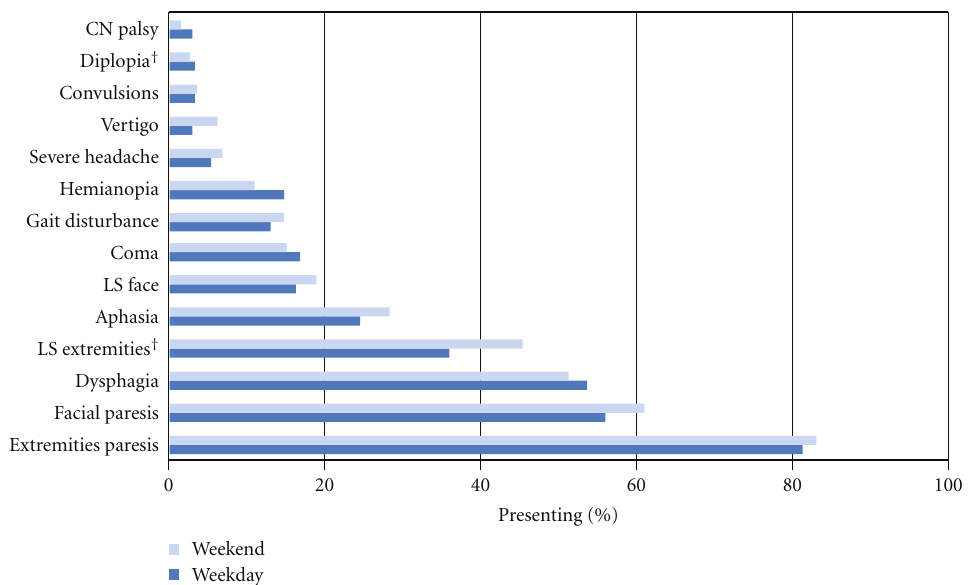
Figure 1: Di ff erences in percent of ischemic strokes presenting with selected symptoms on weekends ∗ and weekdays in the atherosclerosis risk in communities(ARIC) study (1987–2004).Abbreviations: CN palsy: cranialnerve palsy; LS face: lossof sensationin face; LS